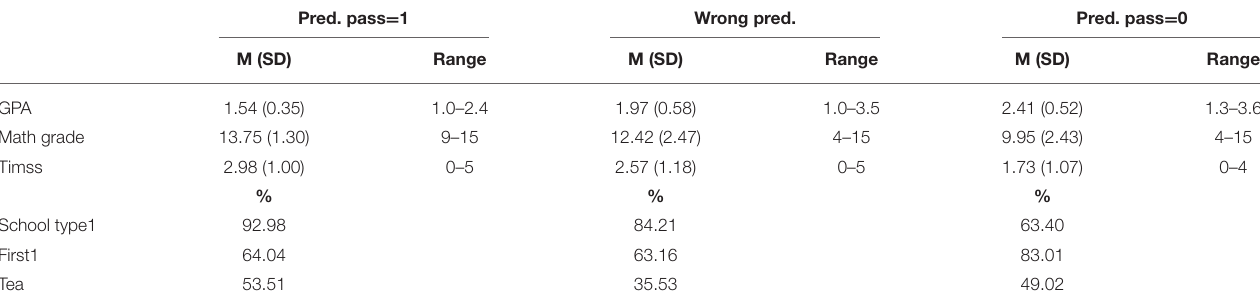
TABLE 10 | Descriptive measures of the groups with correct positive prediction, correct negative prediction and wrong predictions on the complete dataset dataC. Pred. pass = 1 Wrong pred. Pred. pass = 0 M (SD) Range M (SD) Range M (SD) Range